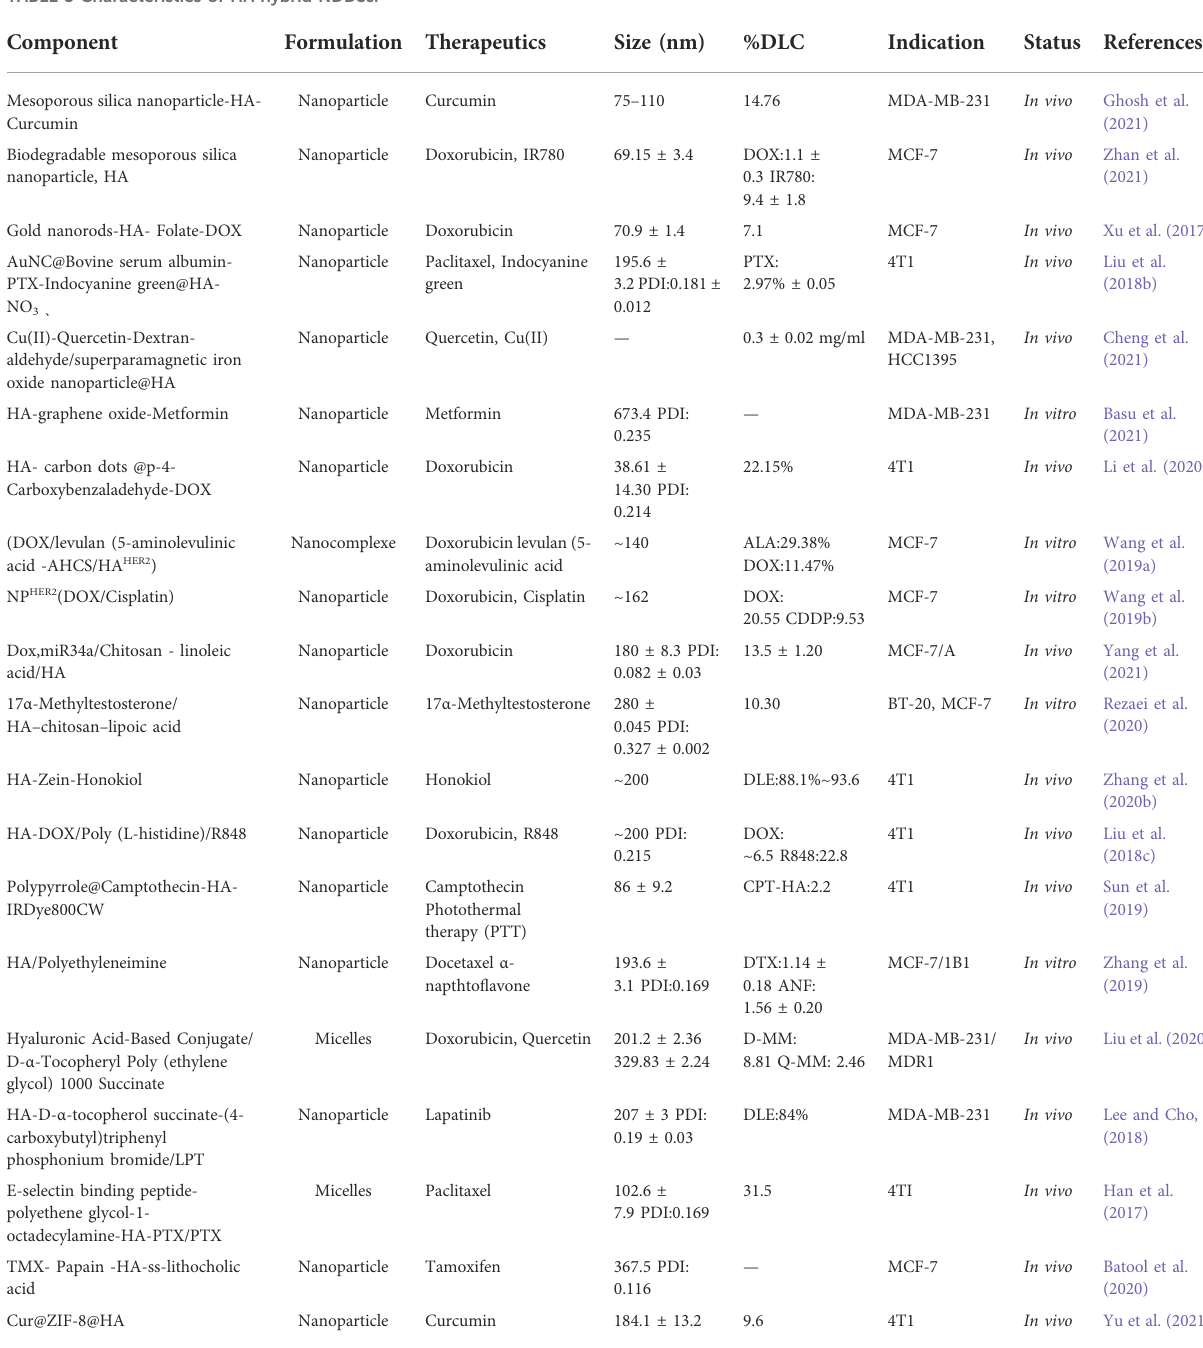
TABLE 3 Characteristics of HA hybrid